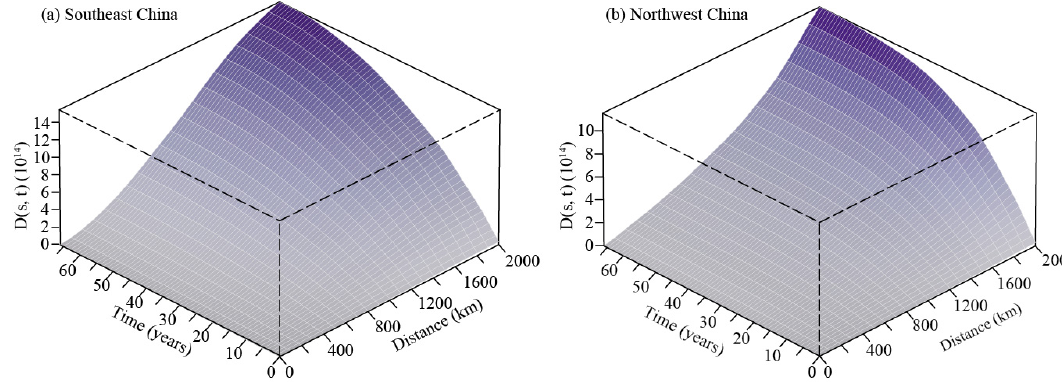
Figure 3. Perspective 3D plot of flash flood disasters in southeast (a) and northwest China (b) .